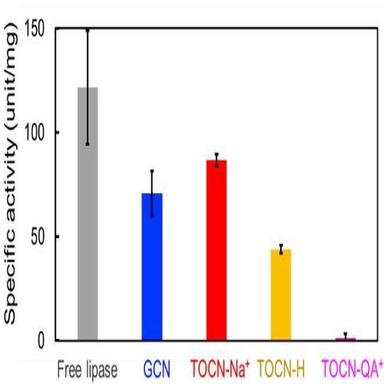
Specific activity of free lipase, compared to that of lipase-supported cryogels during the hydrolysis of olive oil.